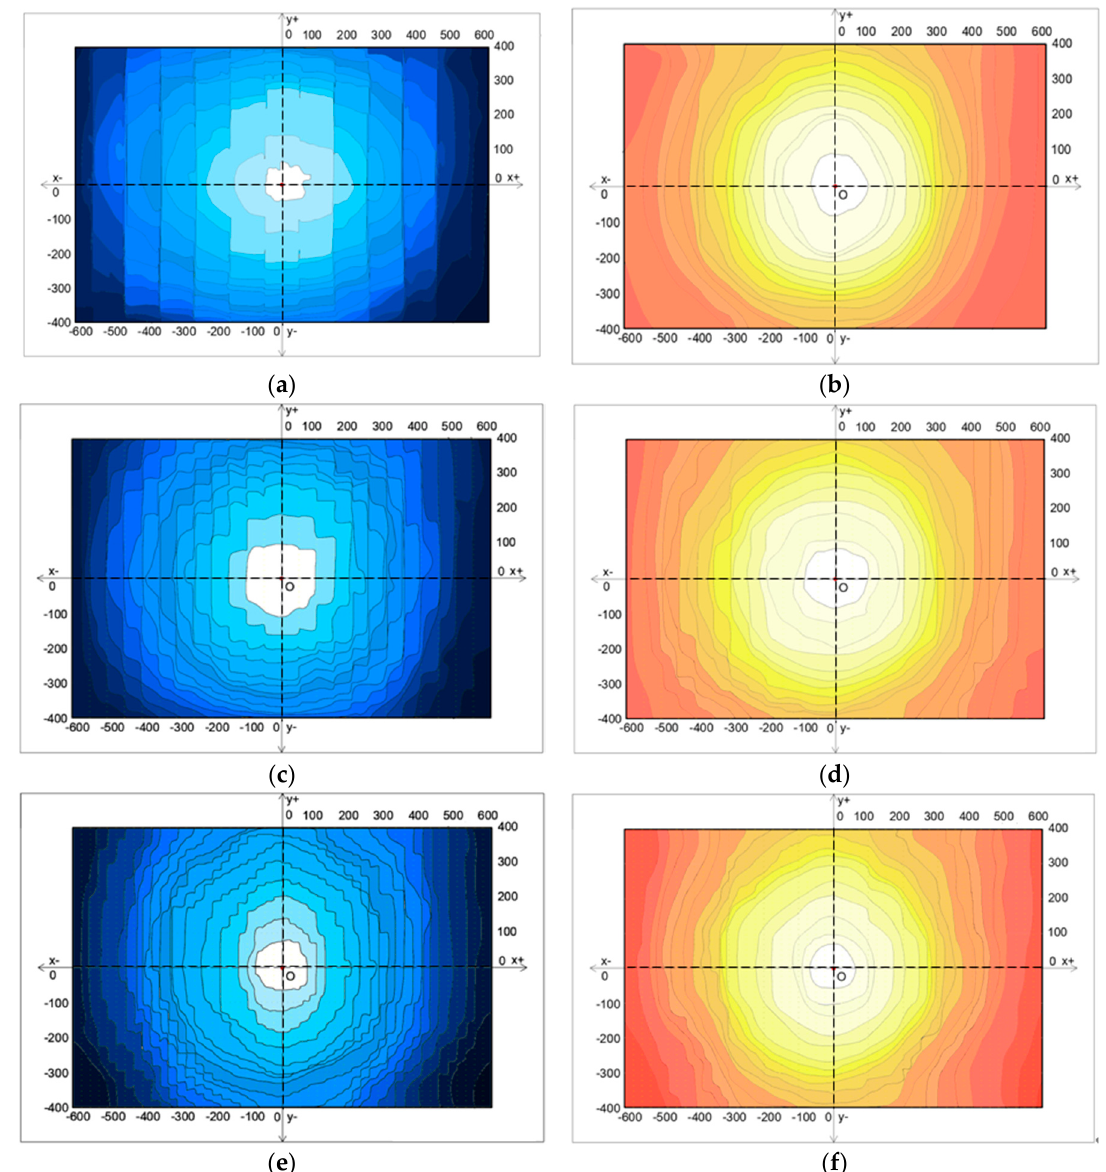
Figure 12. Grout distribution equipotential lines under different saw tooth combinations (mm). ( a ) The outer trace of R1; ( b ) the inner trace of R1; ( c ) the outer trace of R2; ( d ) the inner trace of R2; ( e ) the outer trace of R3; ( f ) the inner trace of R3.